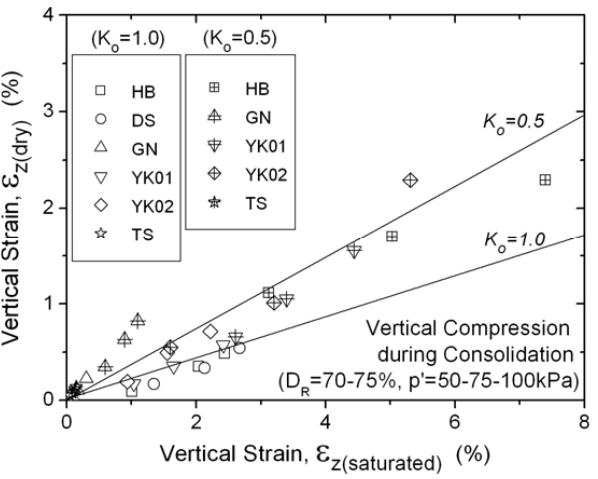
Fig. 10. Comparison of the total vertical compression during con- solidation under dry and saturated Figure 10. Comparison of total vertical compression during consolidation under dry and 3 saturated conditions. 4